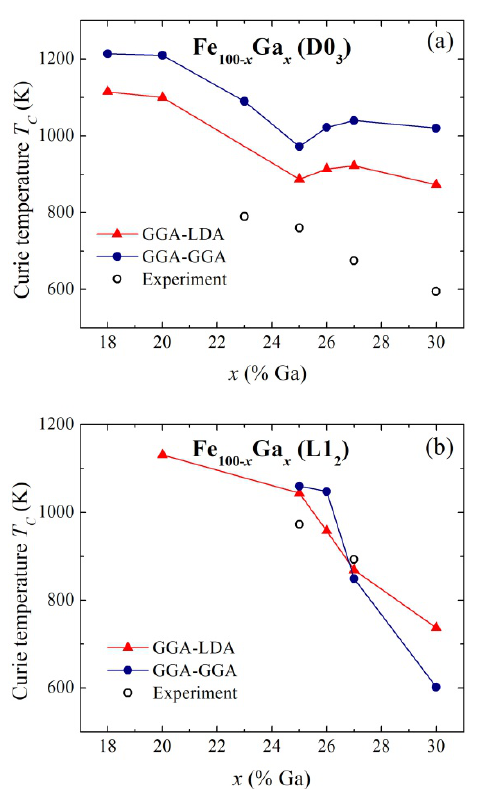
Fig. 4. The Curie temperature for the crystal structures (a) D0 3 and (b) L1 2 of Fe 100- x Ga x alloys in comparison with experimental data, which were taken from [4,